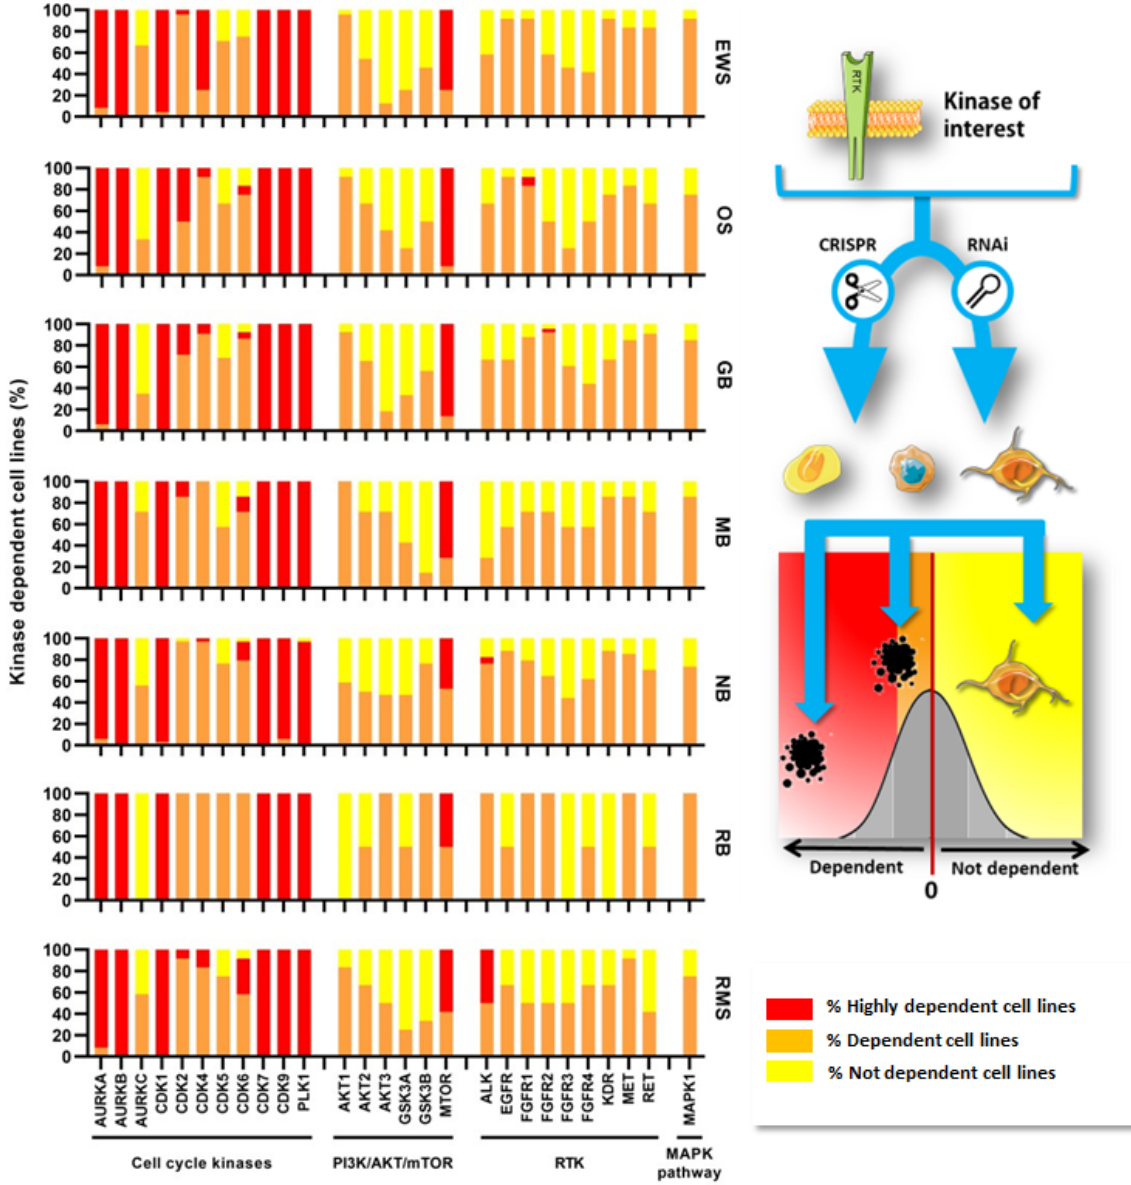
Figure 4. Percentage of pediatric cell lines dependent on the selected group of kinases. Dependency data were imported from the DepMap consortium (CRISPR (DepMap 22Q2 Public + Score, Chronos; https://depmap.org/ portal/ (accessed on 30 October 2022)) and classified as highly dependent, dependent or not dependent. The data were plotted on a histogram where it is possible to see the vulnerability of pediatric cell lines mainly to cell cycle kinases and PI3K/AKT/mTOR families. Cell lines selected included Ewing sarcoma (EWS), osteosarcoma (OS), glioma (GB), medulloblastoma (MB), neuroblastoma (NB), neuroblastoma (NB), retinoblastoma (RB) and rhabdomyosarcoma (RMS). Dependency scores for each cell line are shown in Supplementary Table